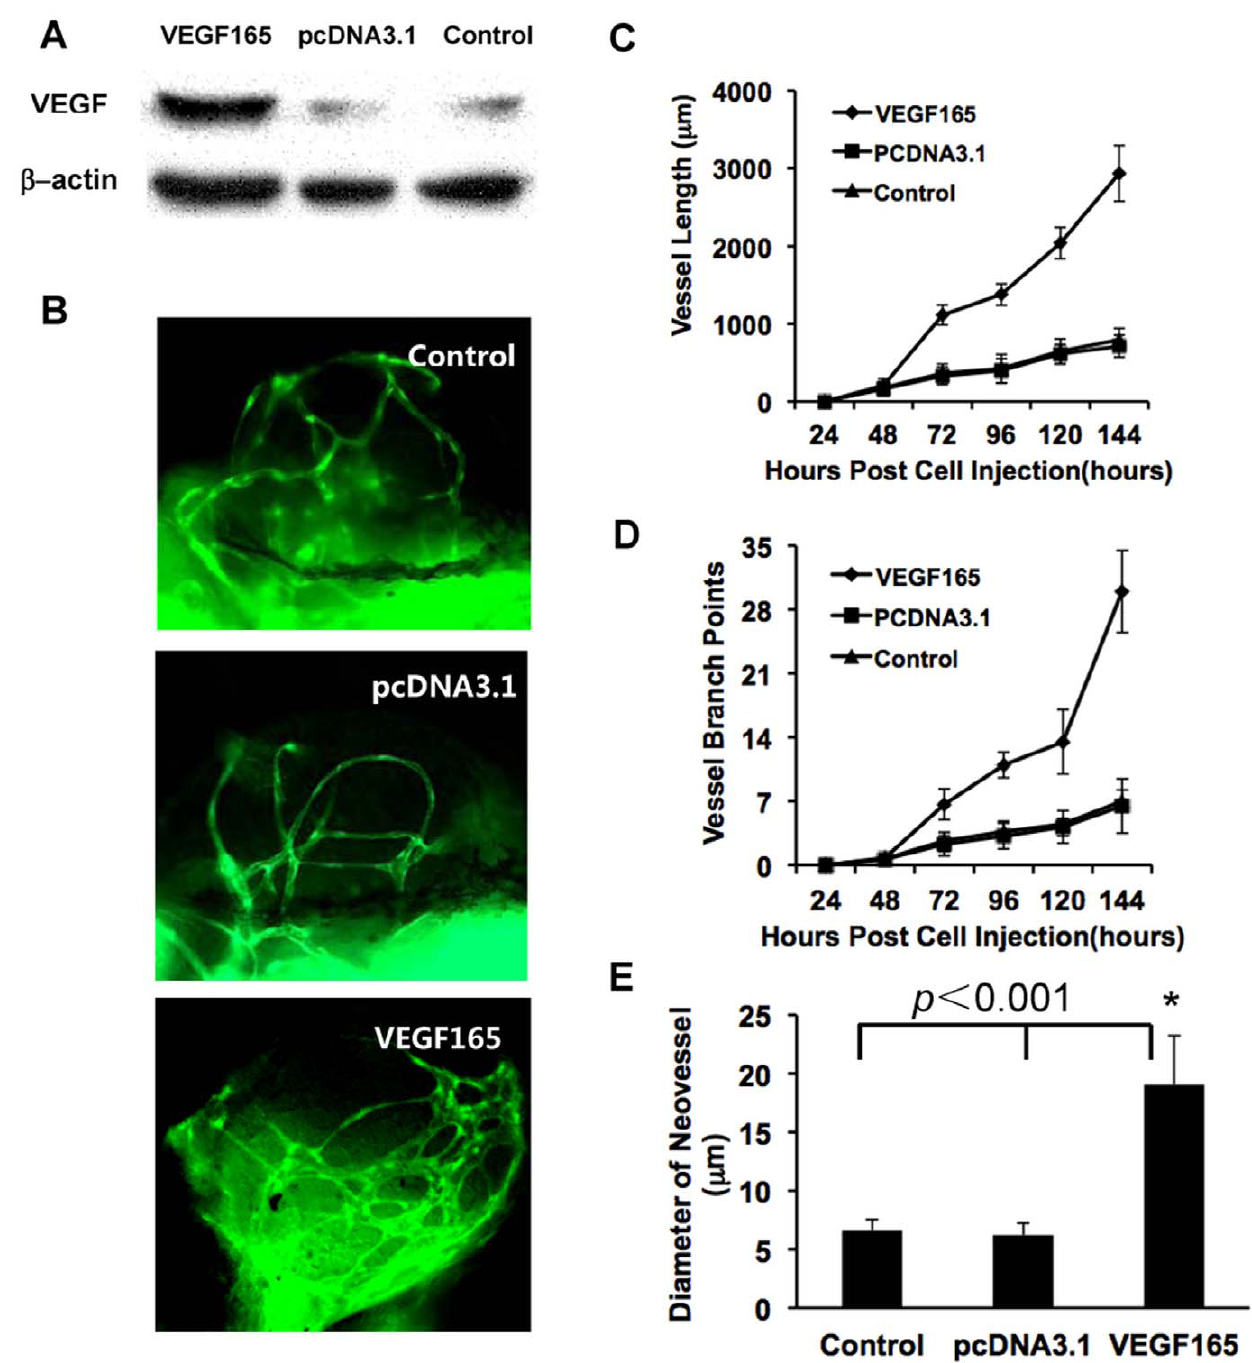
Figure 5. The over-expression of VEGF in B16 cells promoting tumor neovascularization. (A) Weston-blot revealed the expression of VEGF165 at 48 hours post transfection. (B) The tumor-induced neo-vessels were greatly affected by the over-expression of VEGF165 in B16 cells, (C–E) Statistical graphs revealed the changes of vessel length (C), vessel branch points (D) and mean diameters of neovessels (E). Scale bar, 100 m m. doi:10.1371/journal.pone.0021768.g005 angiogenesis. Based on continuously dynamic observations with diverse numerous endothelial loops, thus look like highly irregular high-resolution, we found endothelial cells that had penetrated and chaotic comparing to that in normal tissues. These in vivo observations about the formation process of tumor vasculatures into tumor tissue preferred to connect each other to form endothelial loops rather than continuously growing forward provide a reasonable explanation on cellular level to why the straightly. These endothelial loops were varied significantly in architecture of neovasculatures in tumor always is chaotic and size and shape. The final vasculatures in tumors comprise of heterogeneous. Also, these results provided a good clue to the